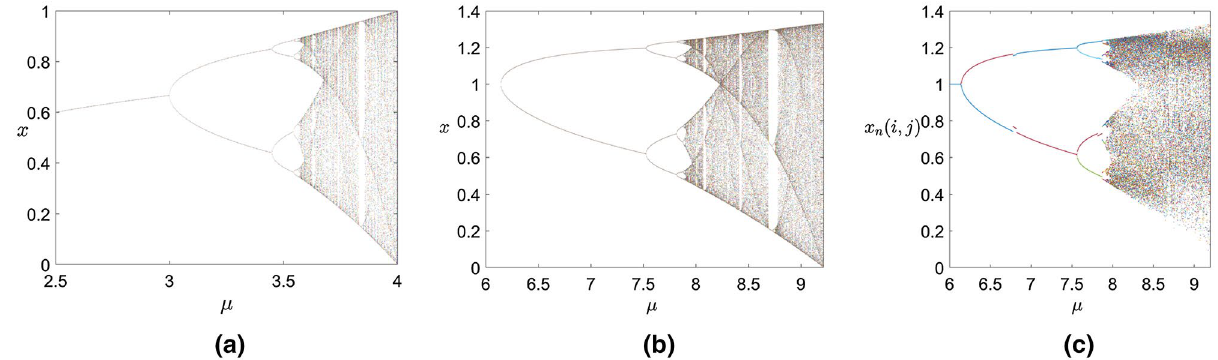
Figure 4. Bifurcation diagrams. ( a ) The traditional logistic chaotic system 52 , ( b ) the fractional-order chaotic logistic system with α = 0.85, r = 0.25 52 , ( c ) the 2DCML fractional-order chaotic system with α = 0.85, r = 0.25, ε = 0.39 .